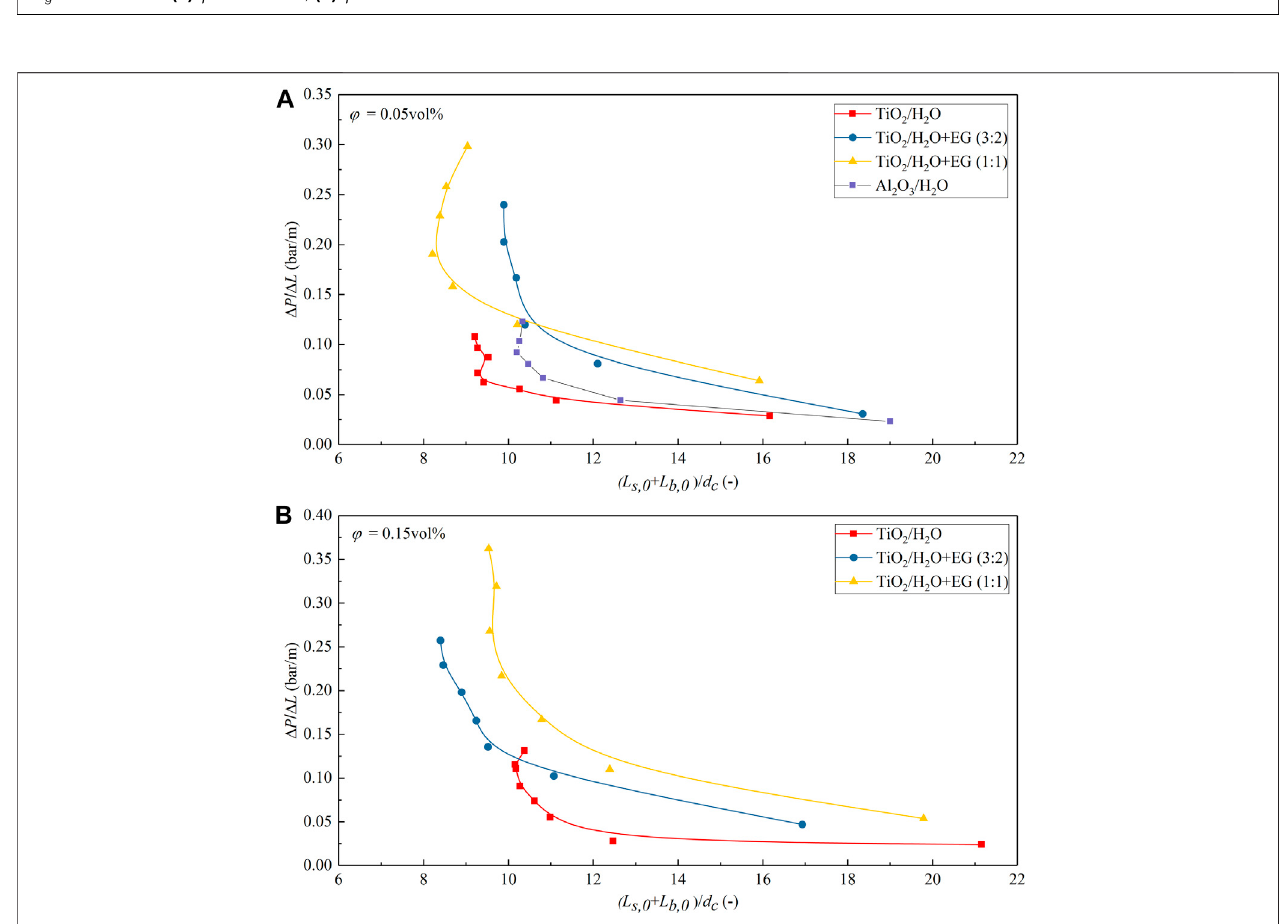
FIGURE11| MeasuredpressuredropofN 2 -nano fl uidslug fl owversusthenormalizedunitcelllength[i.e.,( L b,0 + L s,0 )/ d c ]ataconstantgas fl owrate( Q g (cid:1) 2.77 ml/ min) in the 0.8-mm diameter microchannel. (A) φ (cid:1) 0.05 vol%; (B) φ (cid:1) 0.15 vol%.